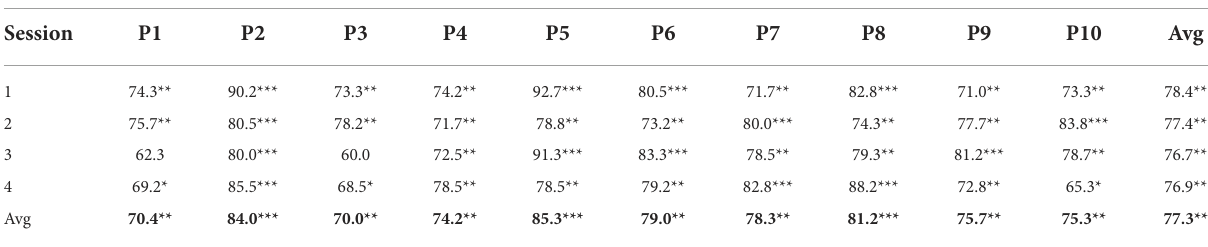
TABLE 2 Average offline classification accuracies for all four